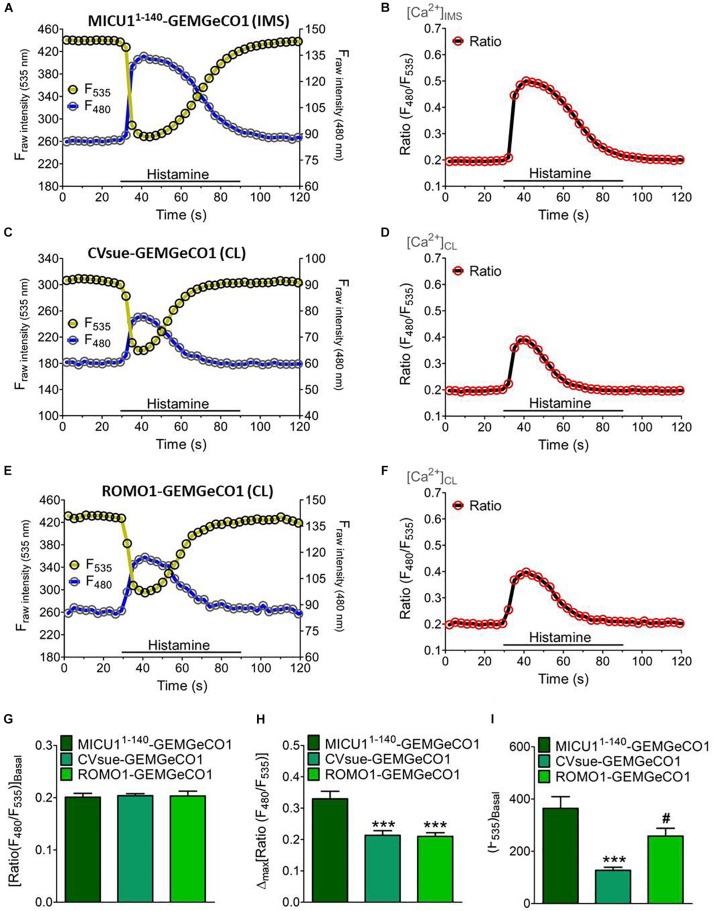
Dynamics of sub-mitochondrial targeted GeCO1-like Ca2+ indicators. Single fluorescence intensities over time of MICU11– 140-GEMGeCO1 (A), CVsue-GEMGeCO1 (C) and ROMO1-GEMGeCO1 (E) in HeLa cells excited at 430 and 480 nm (blue curve) and 535 nm (yellow curve) emission upon stimulation with 100 μM histamine in a nominal Ca2+ free buffer. Calculated ratio (green curves) from the respective left panels by the division of F480 by F535, representing Ca2+ concentration levels ([Ca2+]) in the IMS (B) and the CL (D,F). (G–I) Statistical analysis of HeLa cells expressing either MICU11– 140-GEMGeCO1 (dark green, n = 17), CVsue-GEMGeCO1 (aqua green, n = 16) or ROMO1-GEM-GeCO1 (light green, n = 15) and evaluation of ratiometric signals at basal levels (G) in response to histamine treatment (H) and intensiometric basal intensities at 535 nm reflecting sensor expression levels (I). ∗∗∗P < 0.001 of CVsue-GEMGeCO1 and ROMO1-GEMGeCO1 vs. MICU11– 140-GEMGeCO1 and #P < 0.05 of ROMO1-GEMGeCO1 vs. CVsue-GEMGeCO1.